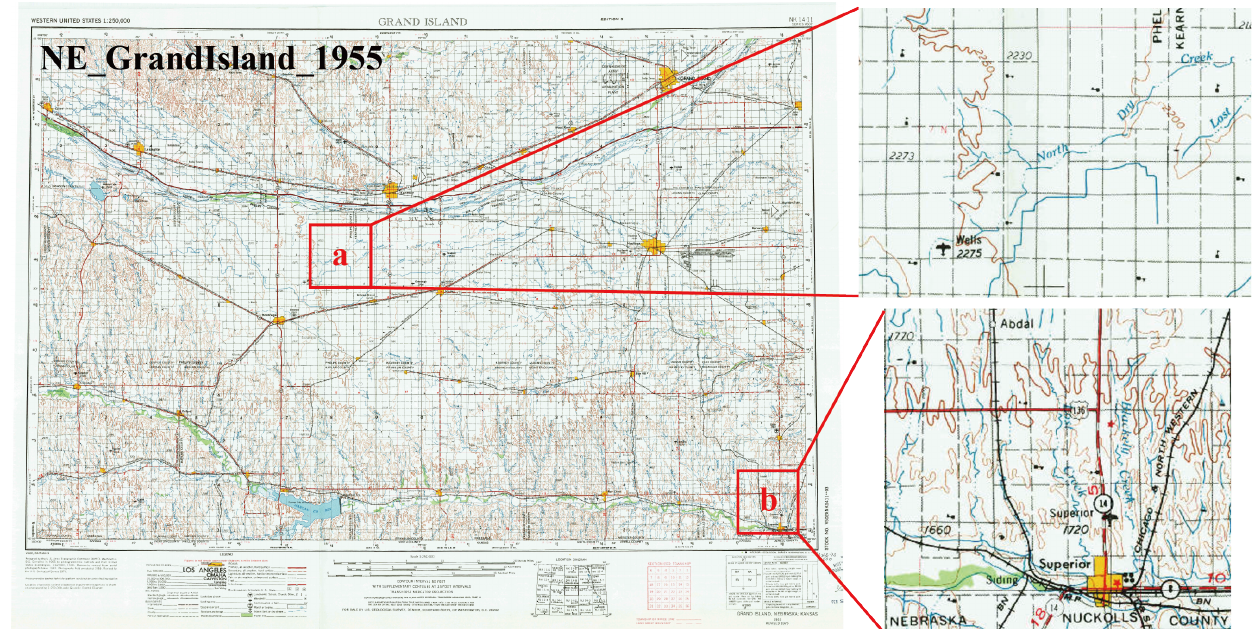
Figure 1. Examples of point symbols on the 1955 STM of Grand Island. ( a , b ) are locally enlarged maps with point symbols. Map source: